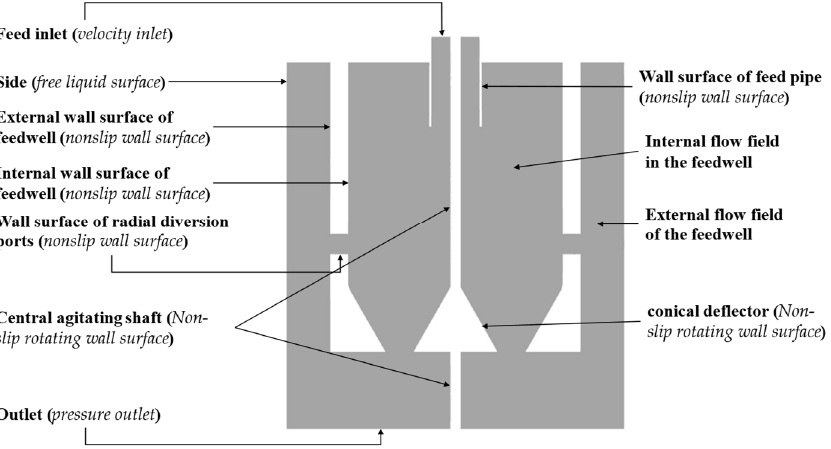
Figure 9. Schematic of the simulation boundary conditions. Table 3. Boundary conditions for the numerical simulation.